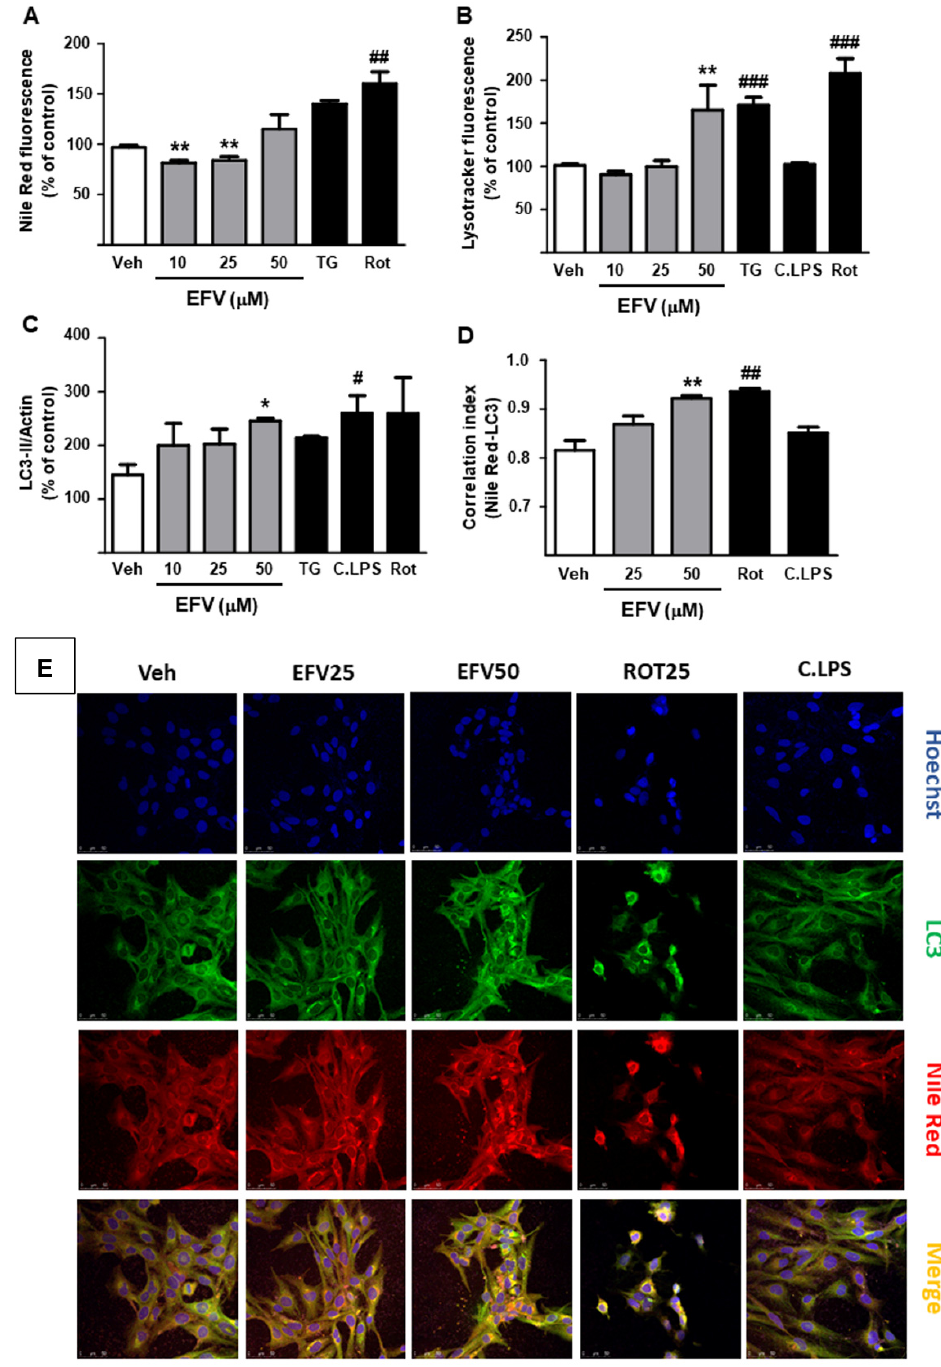
Figure 4. EFV-induced reduction in lipid droplets in LX2 cells is associated with activation of autophagy. ( A ) Intracellular content of lipid droplets evaluated by Nile Red fluorescence (n = 6). ( B , C ) Analysis of autophagy markers: lysosome signal (Lysotracker fluorescence) and protein expression of LC3-II (n = 5–6). ( D ) Correlation index between Nile Red and LC3 fluorescences (n = 5) ( E ) Representative images obtained from confocal microscopy experiments showing Hoechst 33342, LC3, Nile Red and merge (n = 5). All the data (represented as mean ± SEM) were calculated as a percentage of control (untreated cells) and analyzed by a one-way ANOVA multiple comparison test followed by a Newman–Keuls test (* p < 0.05, ** p < 0.01 versus the respective vehicle). Thapsigargin (TG), rotenone (Rot) and cocktail of LPS (C.LPS) were independently analyzed by a Student’s t -test ( # p < 0.05, ## p < 0.01, ### p < 0.001).